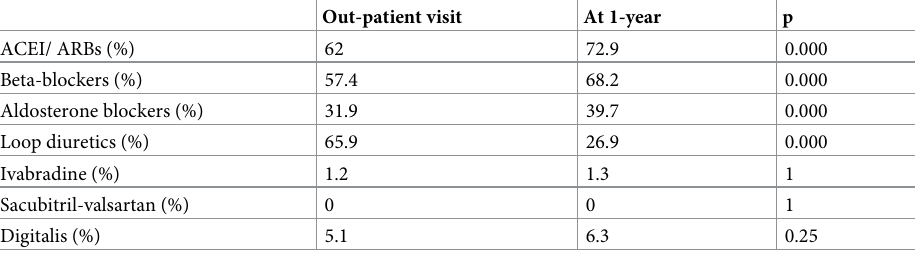
Table 8. Pharmacological treatment of AHF patients during discharge and at 1-year. Out-patient